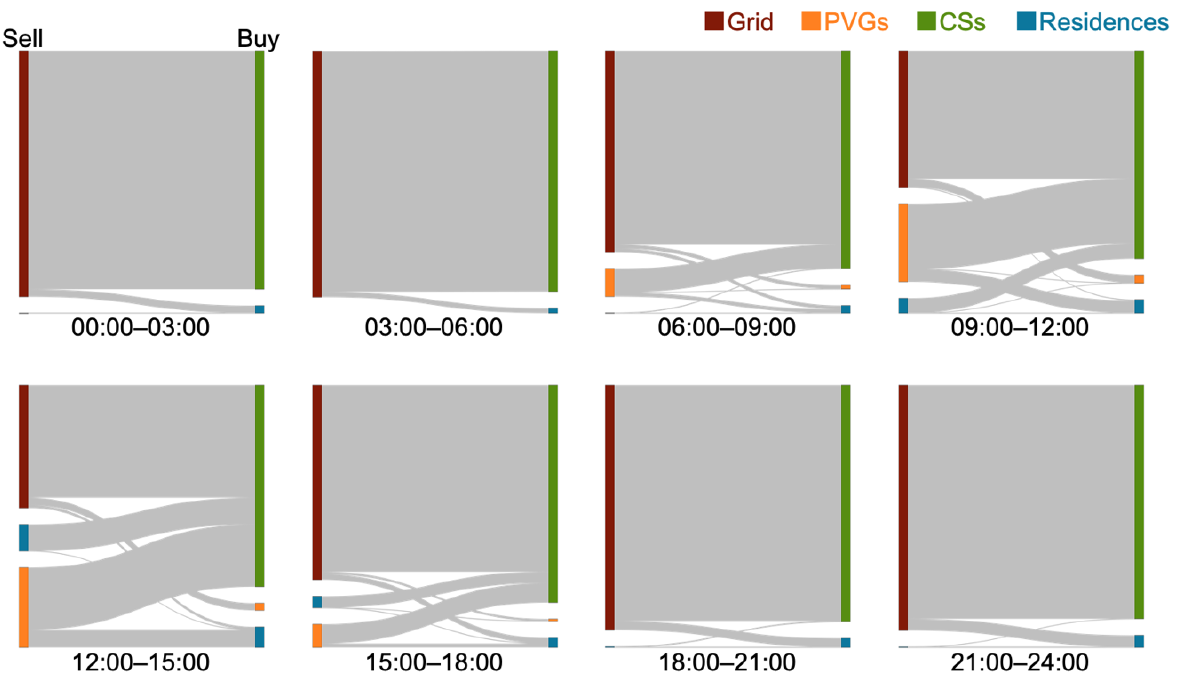
Figure 5. Share of the executed volumes among each agent in the target period.